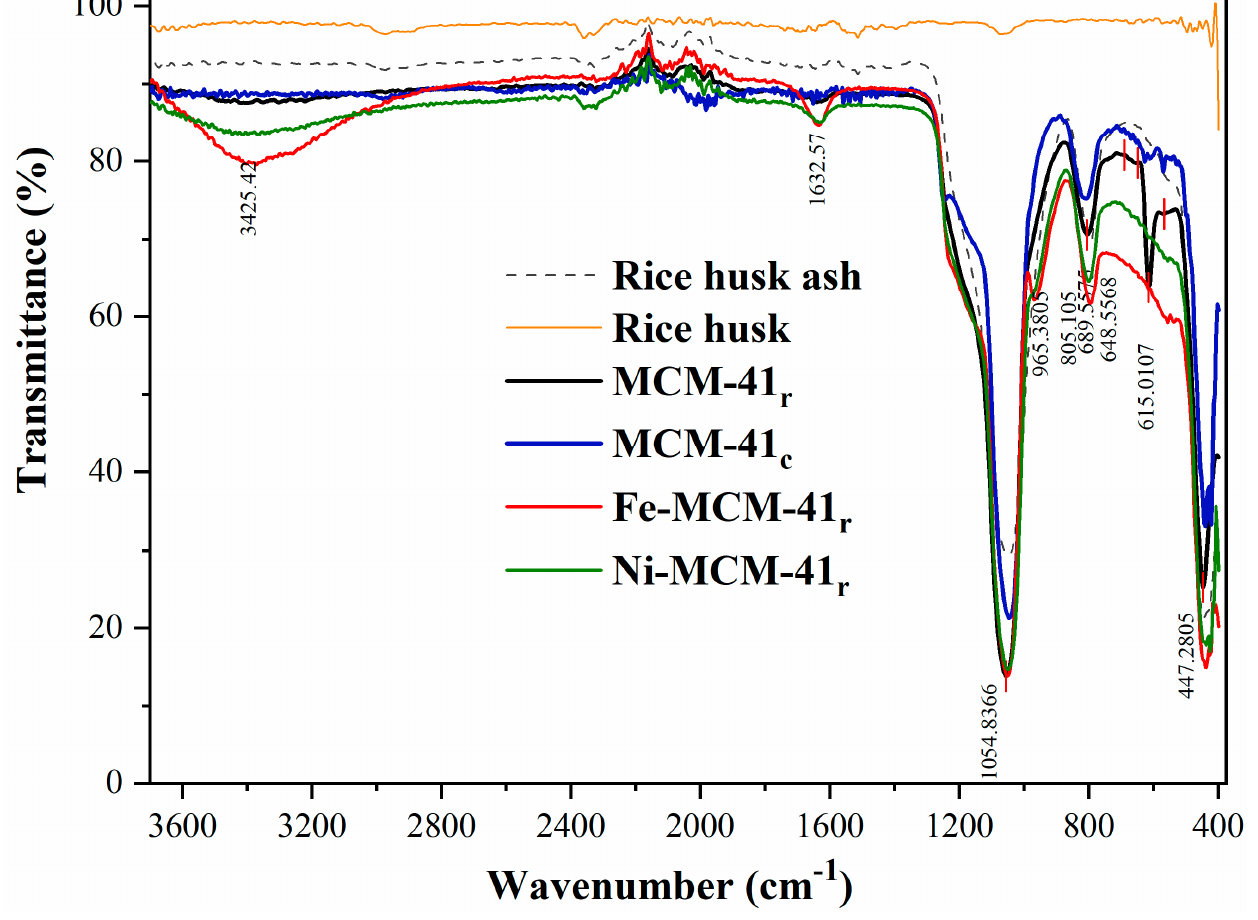
Figure 7. FTIR spectra of RHA, MCM-41 r , MCM-41 c , Fe-MCM-41 r , and Ni-MCM-41 r.